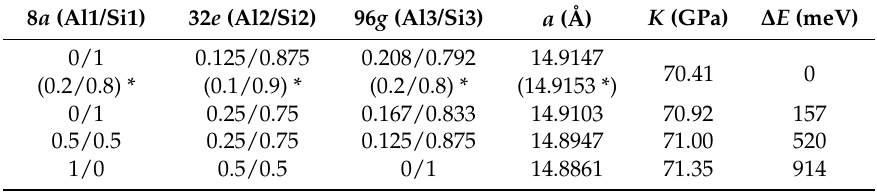
Table 3. The occupancy of framework atoms (Al, Si) on different Wyckoff sites, including 8 a , 32 e , 96 g and the EOS parameters for the energetically stable configuration (the second row) as well as other